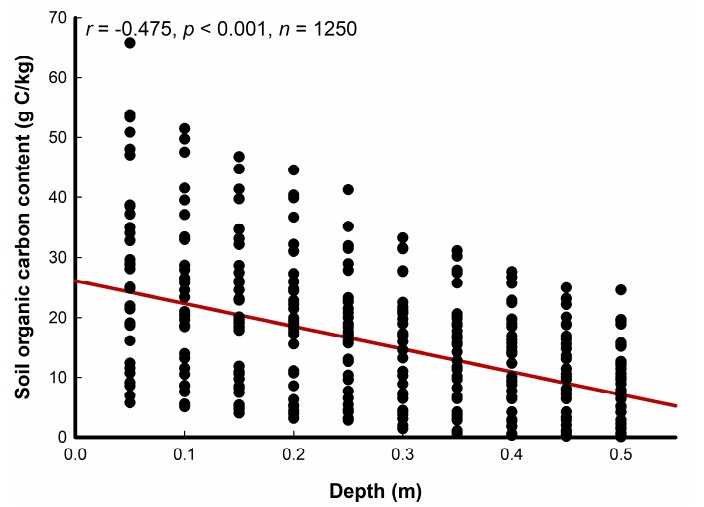
Figure 2. Relationship between soil organic carbon content (g C/kg) and soil depth in ten sites of sabkhas with different vegetation covers along the southern Red Sea coast of Saudi Arabia. Table 1. Summary of statistics of soil bulk density (g/cm 3 ) at different depth intervals in ten sites of sabkhas with different vegetation covers along the southern Red Sea coast of Saudi Arabia.